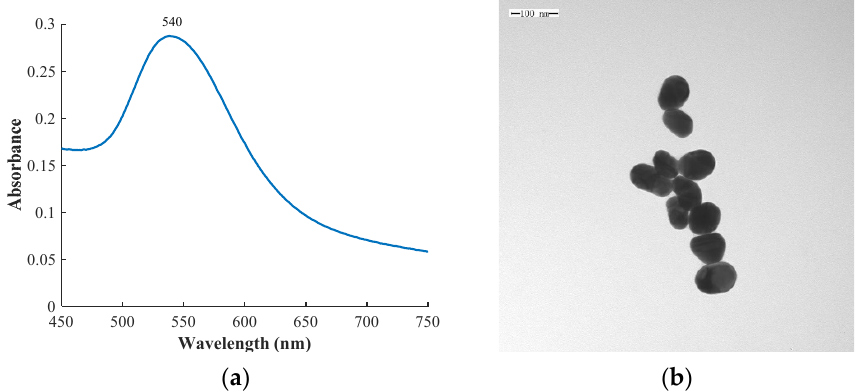
Figure 2. ( a ) UV–vis absorption spectra of gold colloid; ( b ) TEM image of gold colloid.